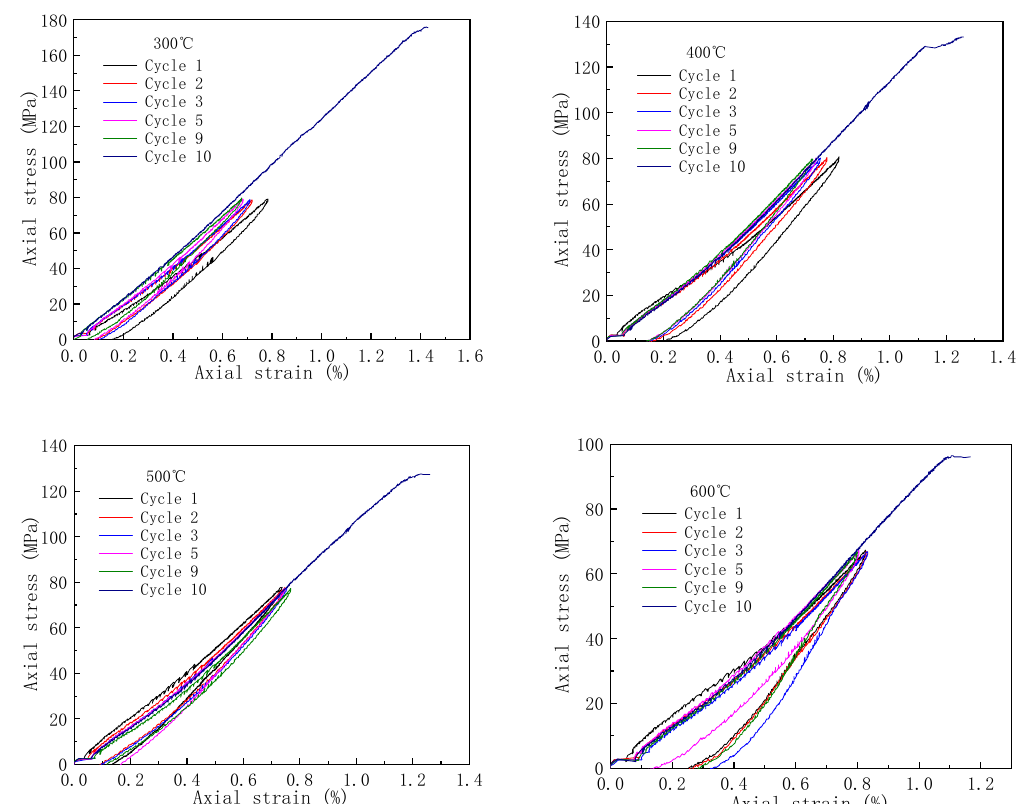
Figure 3. Stress–strain curves of granite sample when the upper limit of cyclic stress is 70% of UCS at six upper limit cyclic temperatures.